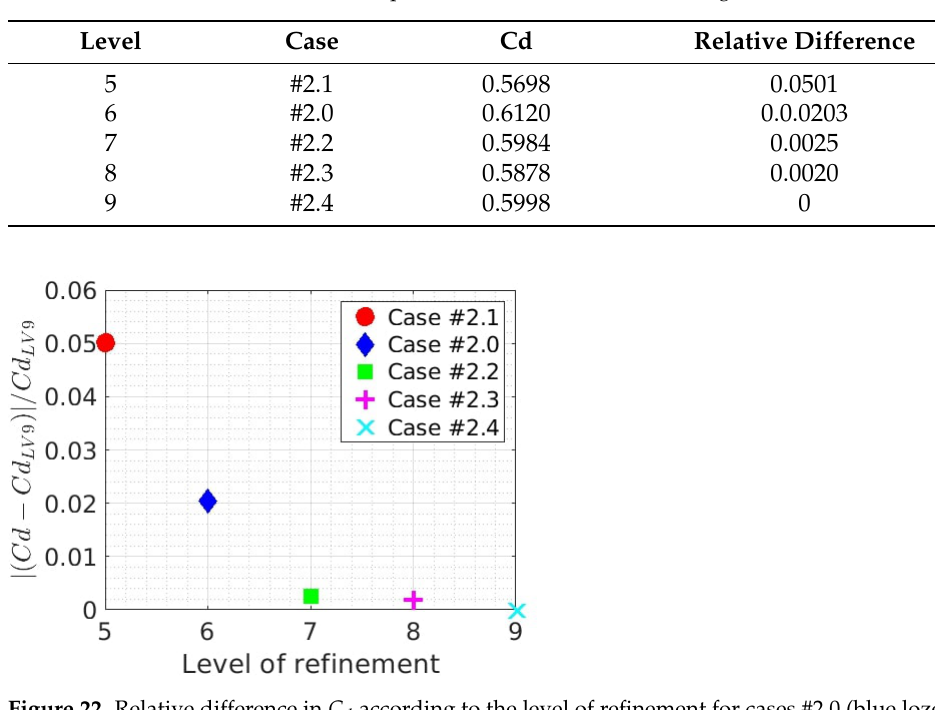
Table 6. Summary of the Cd values after 1 s of simulation depending on the level of refinement on the blades. The relative difference compared to the level 9 simulation is given in the last column.